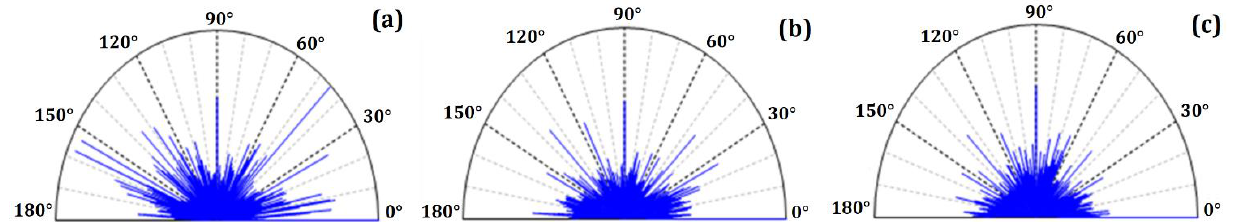
Figure 4. Surface texture directions for ( a ) P 0 , ( b ) P 500 , and ( c ) P 1000 . All systems presented a similar microtexture, as the direct texture parameters did not show any statistically significant differences ( p -value > 0.05).